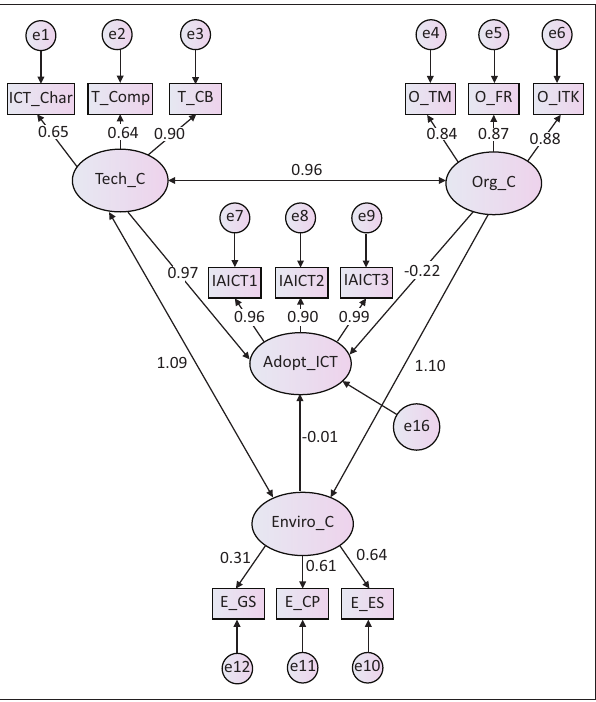
FIGURE 2: Standardised residual